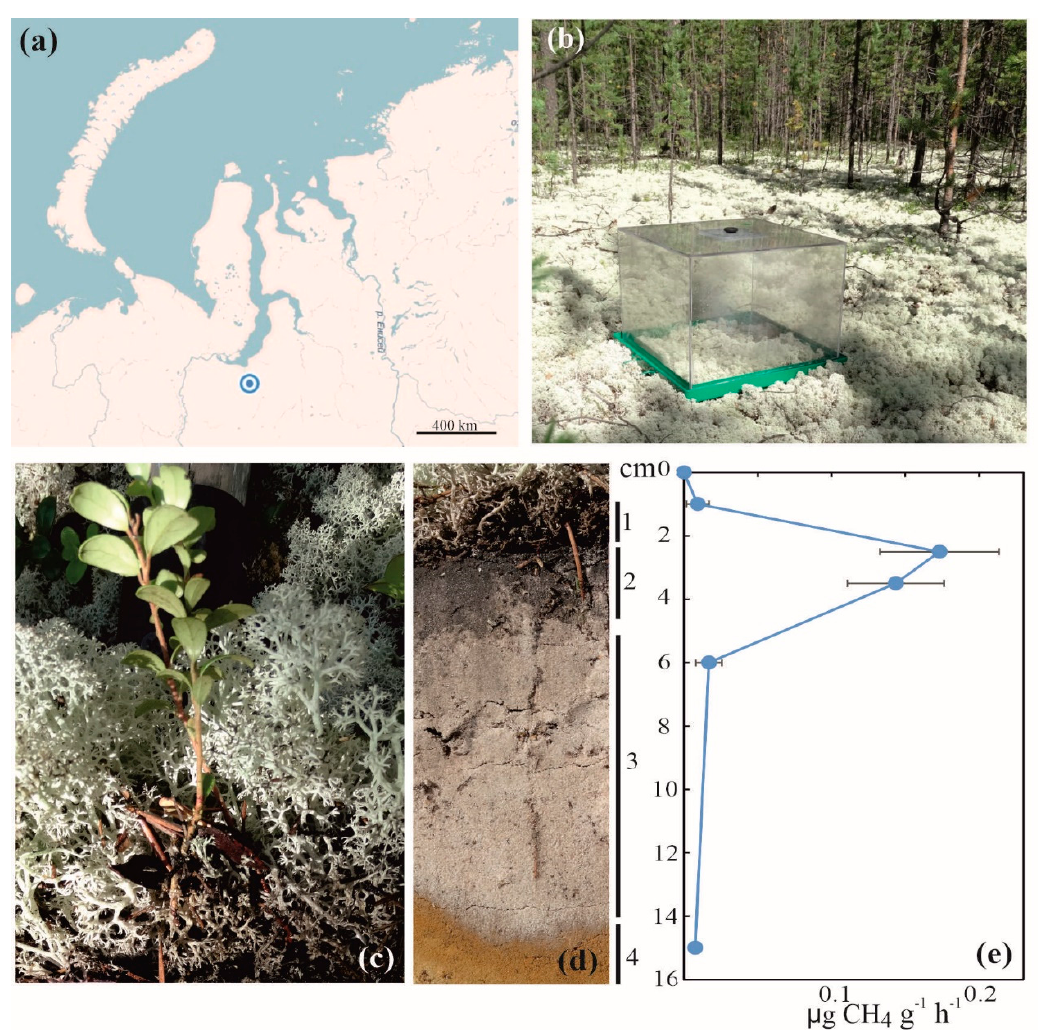
Figure 1. Location and some characteristics of the study site: ( a ) location of the study site on the map of northern Russia; ( b ) CH 4 flux measurements by static chambers; ( c ) vegetation cover at the study site; ( d ) soil profile: 1—litter, 2—organic layer, 3—gray sand, and 4—sandy subsoil; ( e ) distribution of CH 4 oxidation activity over the soil profile.